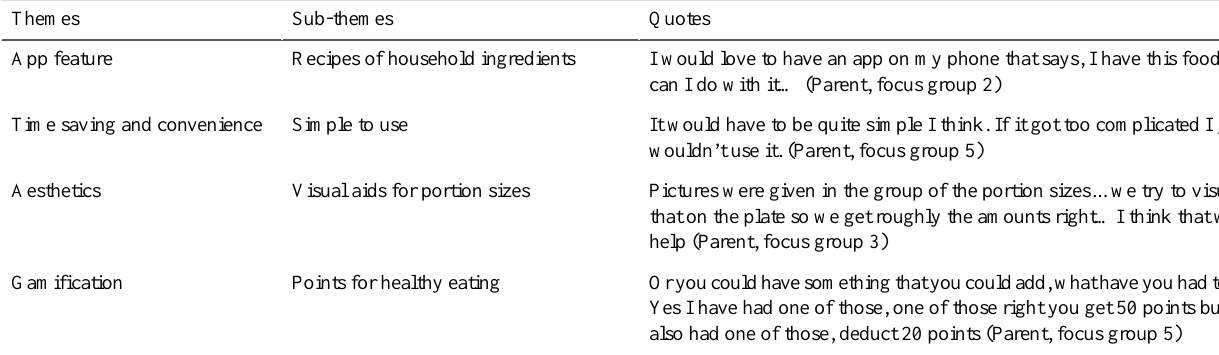
Table 1. Excerpt of parents preferences for app